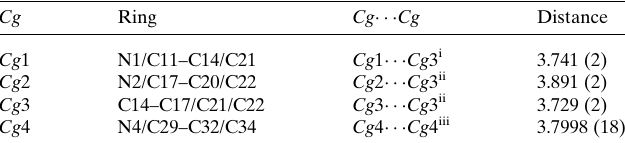
Table 3 (cid:2) – (cid:2) stacking interactions (A˚ ).